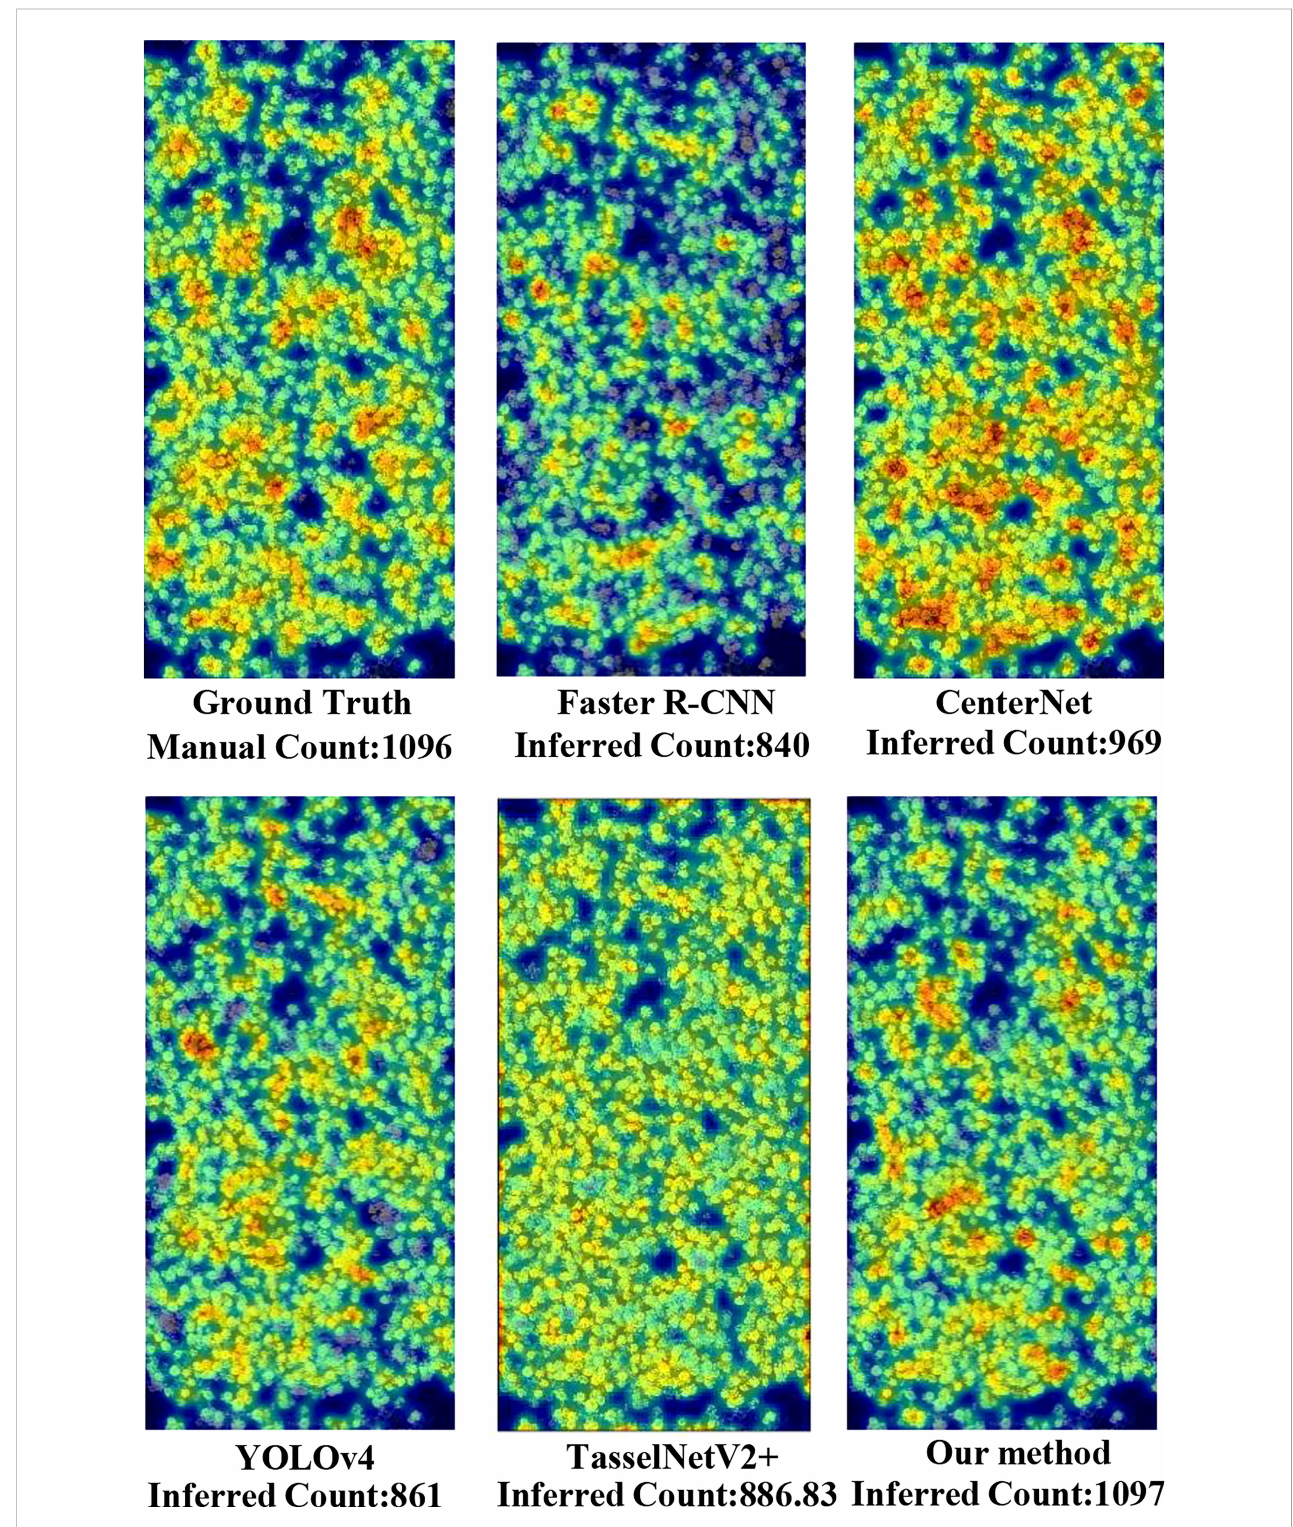
FIGURE 6 Comparison of visualization results between fi ve networks and the ground